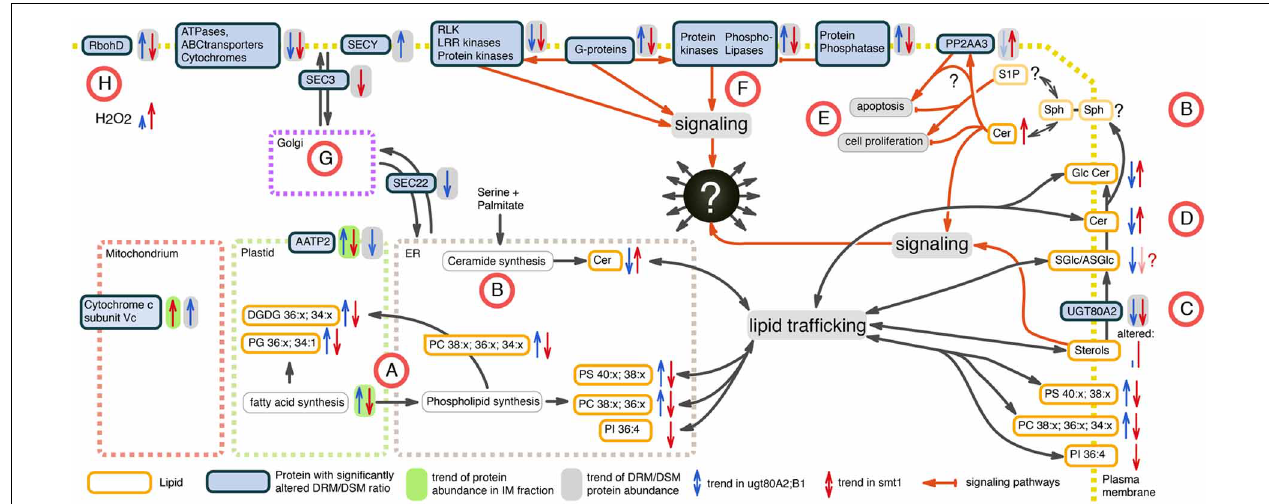
FIGURE 6 | Working model of altered proteins and lipids in smt1 (blue) and ugt80A2;B1 (red) based on the set of identified core proteins from network analysis. (A) Fatty acid and glycerolipid synthesis is decreased in smt1 and increased in ugt80A2;B1 , with significant alterations in abundances of distinct glycerolipids. (B) Alteration in ceramide (Cer) de novo synthesis was not observable. Additionally, alterations in activity of salvage synthesis pathways (Van Brocklyn and Williams, 2012) could explain changes in abundances of ceramides in the mutants. (C) Glycosylation of sterols (SGlc/ASGlc) might additionally happen in plasma membrane catalyzed by UGT80A2, which was depleted from DRM in both mutants. (D) GlcCer levels are inversely altered in both mutants implying an additional sterol-dependent